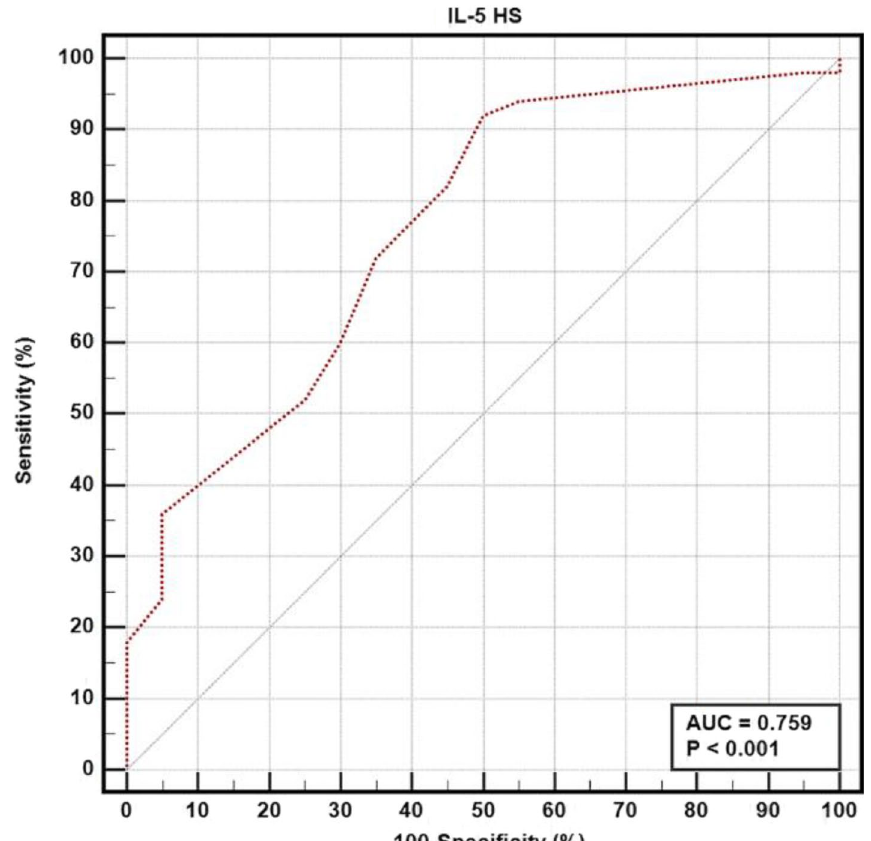
Fig. 4 Response-operating characteristic (ROC) curve analysis for discrimination between cases and controls using IL-5 HS. IL-5 HS has fair discriminative value. Area under the ROC curve (AUC) specificity 50%, J-index = =